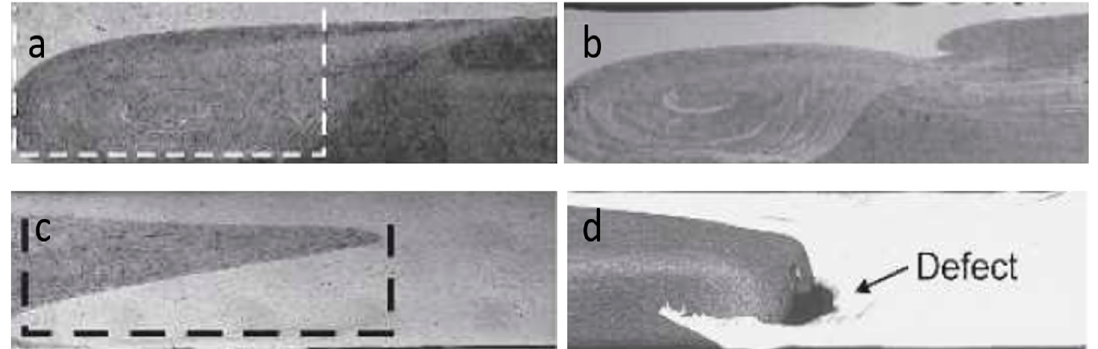
Figure 13. Macroscopic image of dissimilar joints with darker areas as AA5083: ( a , b ) AA5083 on advancing side; ( c , d ) AA6082 on advancing side with defect [76] .